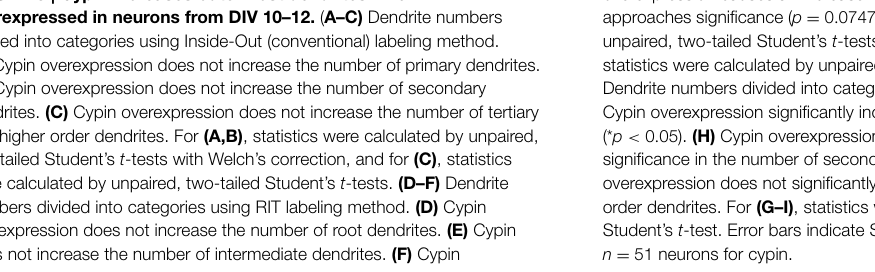
overexpression causes an increase in the number of terminal dendrites that approaches significance ( p = 0 . 0747 ). For (D,E) , statistics were calculated by unpaired, two-tailed Student’s t -tests with Welch’s correction, and for (F) , statistics were calculated by unpaired, two-tailed Student’s t -tests. (G–I) Dendrite numbers divided into categories using Tips-In labeling method. (G) Cypin overexpression significantly increases the number of primary dendrites ( * p < 0 . 05 ). (H) Cypin overexpression results in an increase that approaches significance in the number of secondary dendrites ( p = 0 . 0503 ). (I) Cypin overexpression does not significantly change the number of tertiary and high order dendrites. For (G–I) , statistics were calculated by unpaired, two-tailed Student’s t -test. Error bars indicate SEM. n = 35 neurons for GFP, and n = 51 neurons for